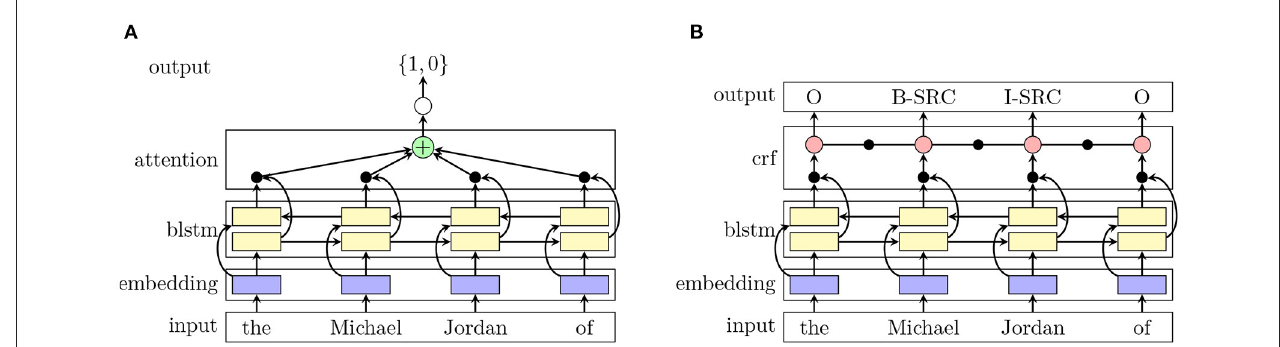
FIGURE 1 | (A) Shows the BLSTM-ATT architecture for the classification task and panel. (B) Shows the BLSTM-CRF architecture for the sequence tagging task.